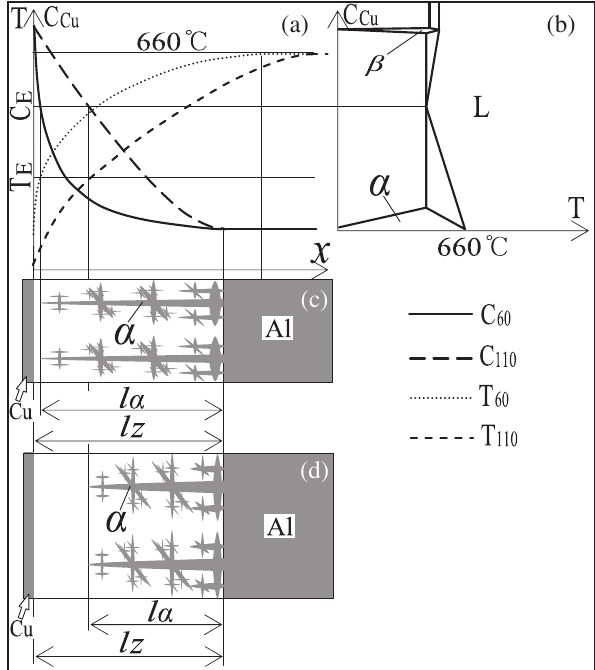
Figure 5: Schematic diagram of the solidification process in the transition layer: (a) Concentration and temperature distribution; (b) Phase diagram of Al-Cu alloy; (c) Solidification process at 60 s after pouring; (d) Solidification process at 110 s after pouring. T- temperature; C Cu - concentration of Cu; C E - eutectic composition; x - distance away from pure Al; T l α - E - eutectic temperature;